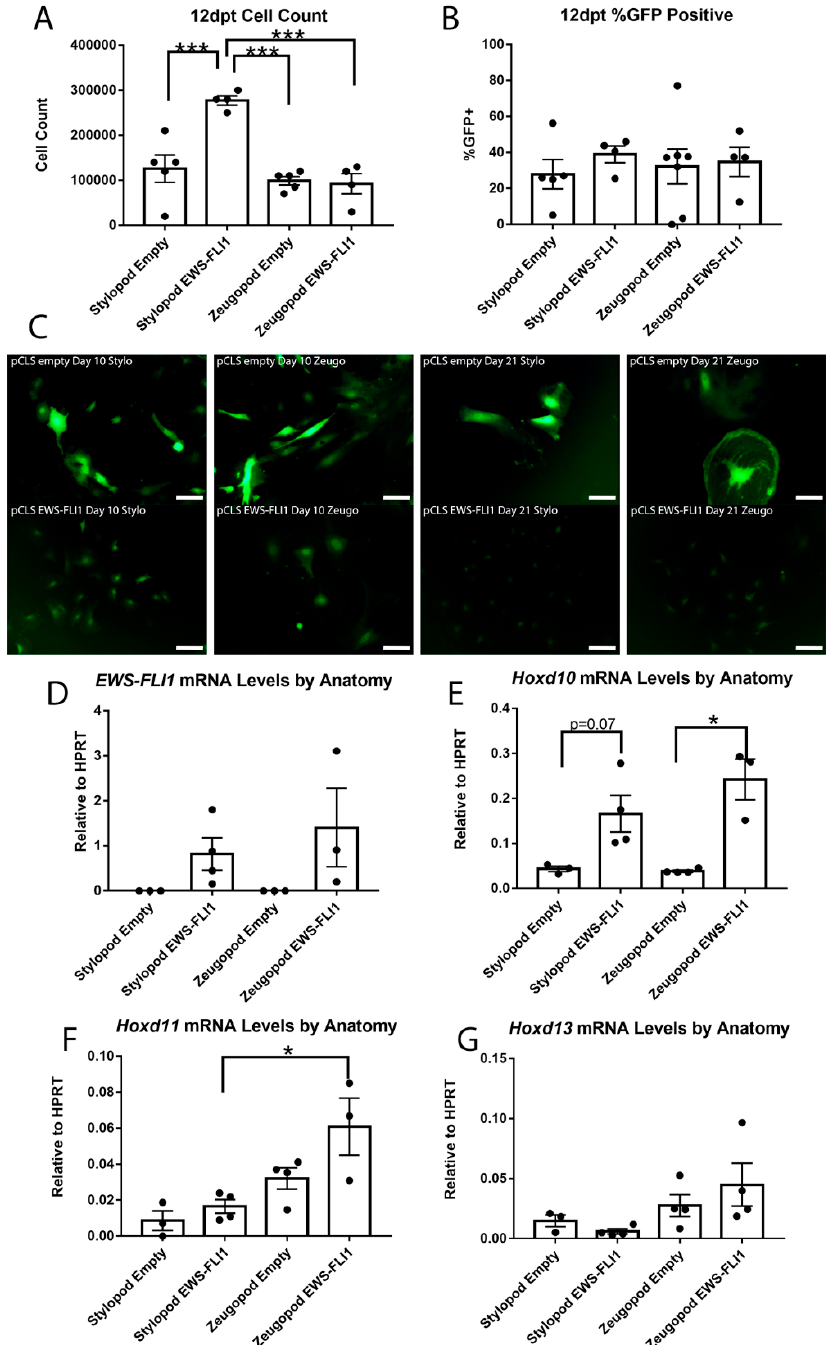
Figure 4. EWS-FLI1 changes cell phenotype in stylopod and zeugopod eSZs twelve days post transduction (dpt). ( A ) Cell count at 12 dpt. ( B ) Flow cytometry for GFP expression at 12 dpt. ( C ) Micrographs of GFP expressing cells with empty and EWS-FLI1 transduction at 10 and 21 dpt. Scale bars represent 50 µm. ( D ) EWS-FLI1 mRNA levels relative to HPRT . ( E ) Hoxd10 mRNA levels relative to HPRT . ( F ) Hoxd11 mRNA levels relative to HPRT . ( G ) Hoxd13 mRNA levels relative to HPRT . *** p ≤ 0.001; * p ≤ 0.05. Error bars are SEM.